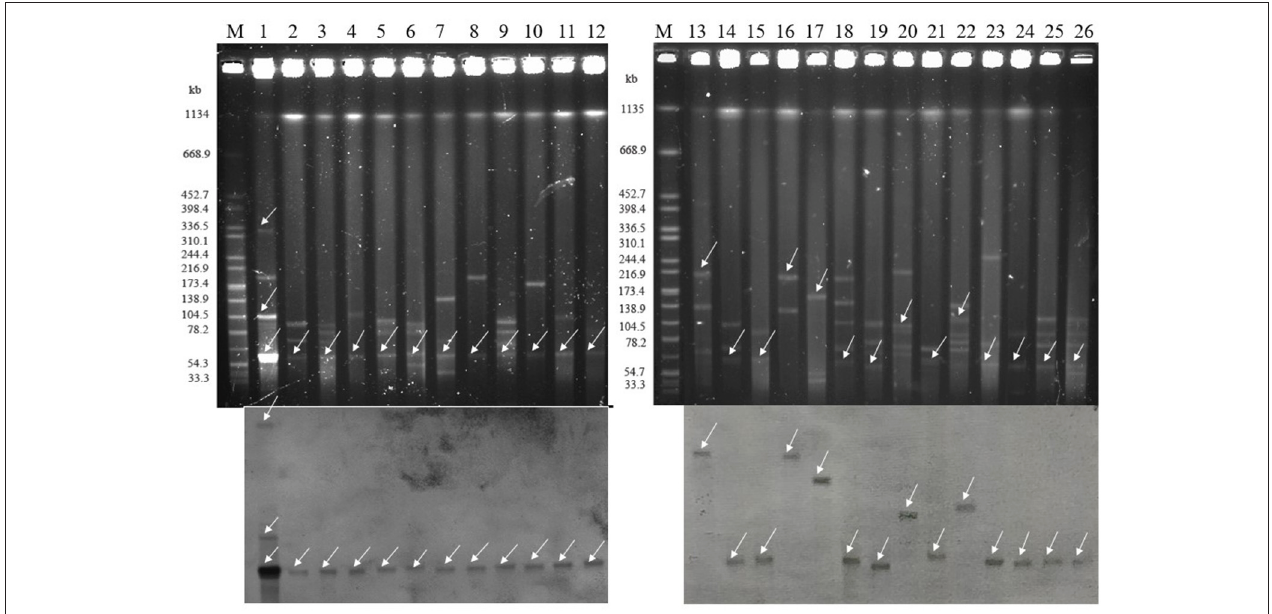
FIGURE 4 | Isolation and determination of plasmids harboring the bla NDM gene in 26 clinical and transconjugants ( Top : S1-nuclease PFGE patterns; Bottom : Southern blotting with a bla NDM specific probe). The arrows represent thelocation of linear plasmid DNA hybridized with the bla NDM specific probe. M: Braenderup H9812 Marker; lane 1: E5; lane 2: E7; lane 3: E12; lane4: E22; lane 5: E21; lane 6: E28; lane 7: E36; lane 8: E37; lane 9: E49; lane 10: E33; lane 11: E47; lane 12: E48; lane 13: E15; lane 14: E3; lane 15: E20; lane 16: E8; lane 17: E44; lane18: E32; lane 19: E53; lane 20: E6; lane 21: E16; lane 22: E38; lane 23: E39; lane 24: E41; lane 25: E45; lane 26: